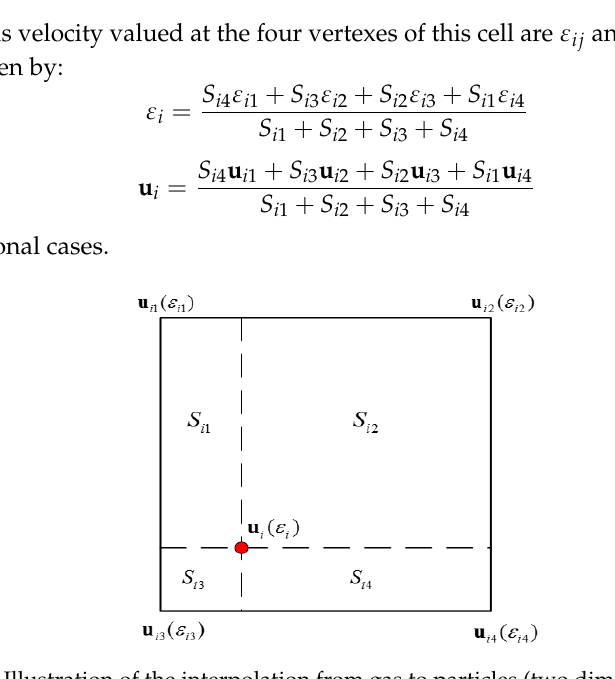
Figure 2. Illustration of the interpolation from gas to particles (two dimensional cases).